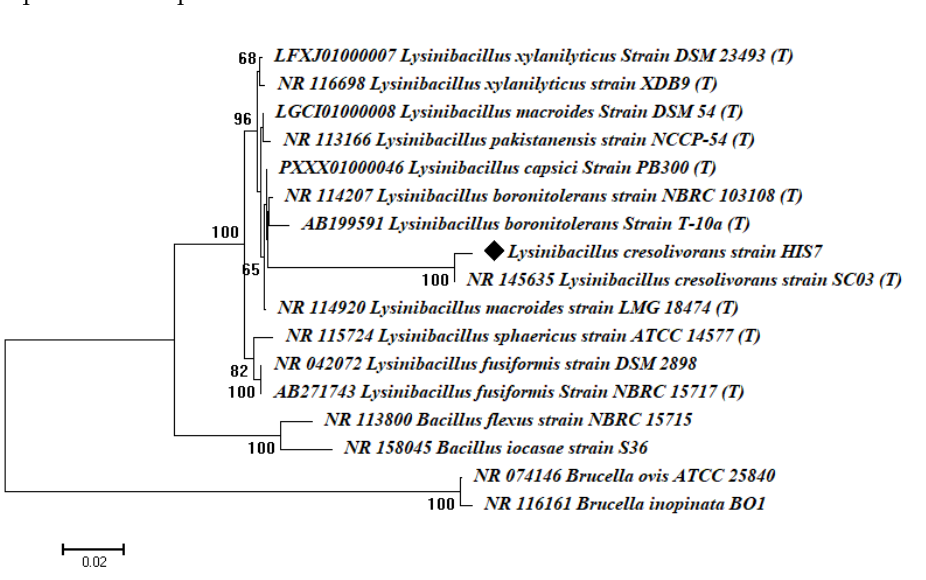
Figure 2. Phylogenetic tree of 16S rRNA sequences of the bacterial isolate HIS7 compared with the retrieved sequences of NCBI GenBank. The matrices of tree reconstruction were determined using a neighbor-joining approach. A bootstrap value greater than 60% (1000 replicates) was indicated on the branch. The number of substitutions per sequence is shown on the scale.